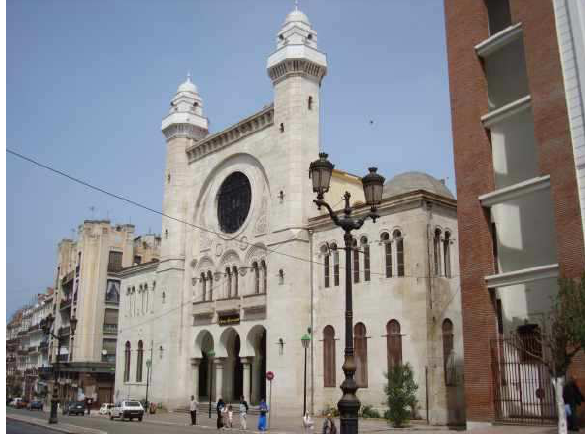
Figure 1. synagogue of Oran 1927.